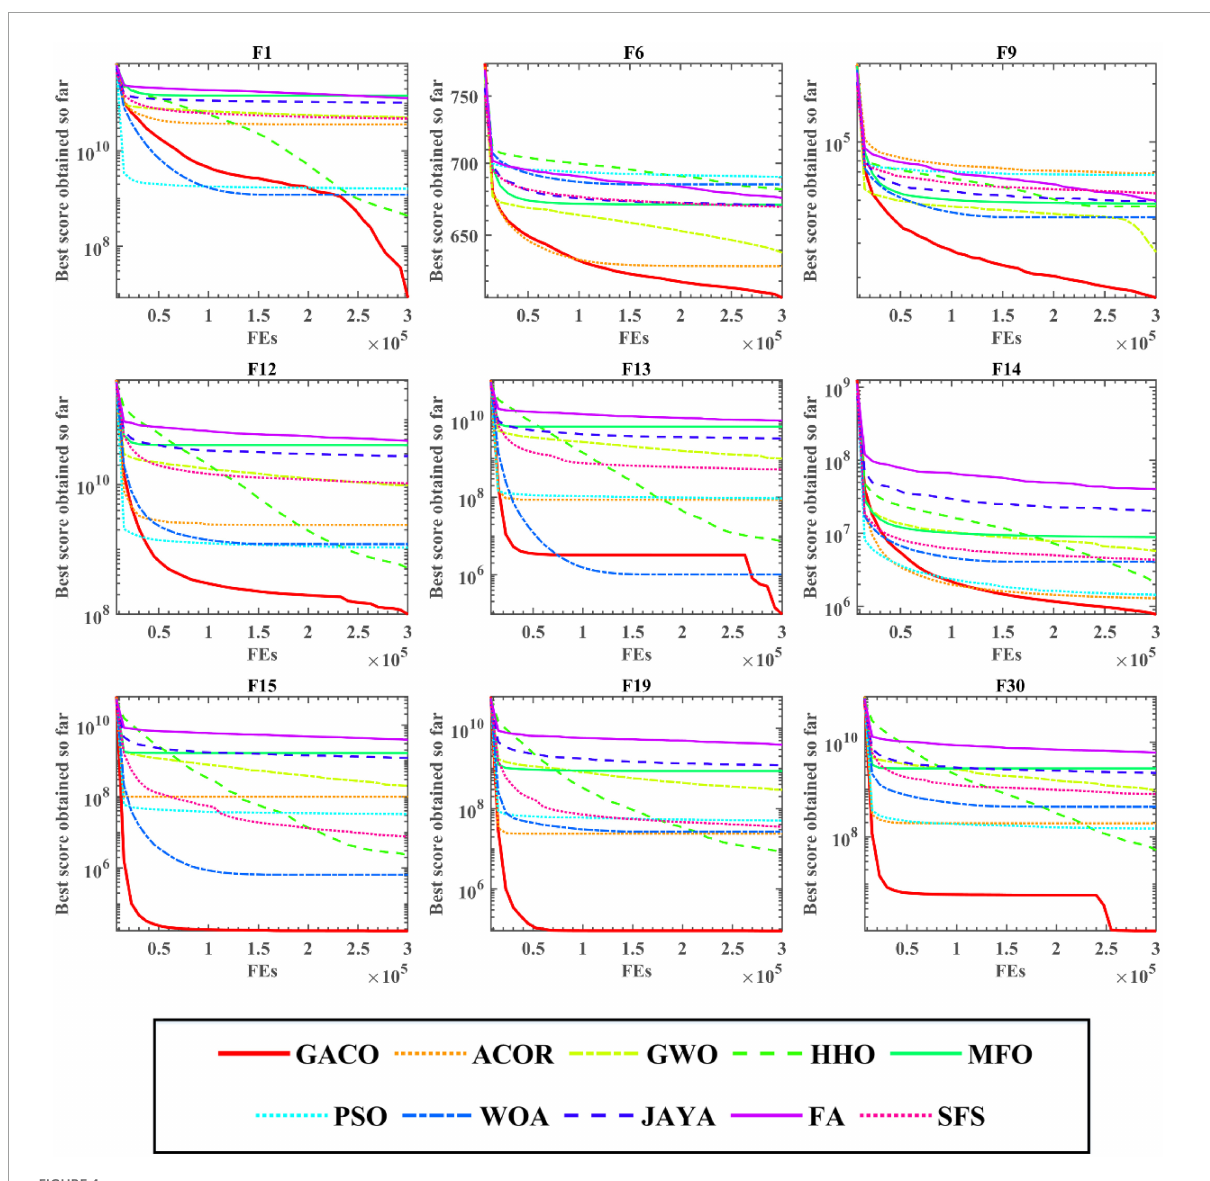
FIGURE4 The convergence curves of GACO and basic algorithms on some